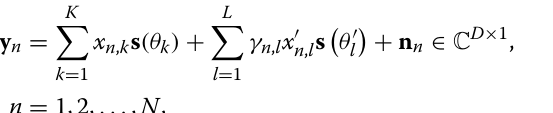
to the receiver probability p l . Accordingly, the n -th